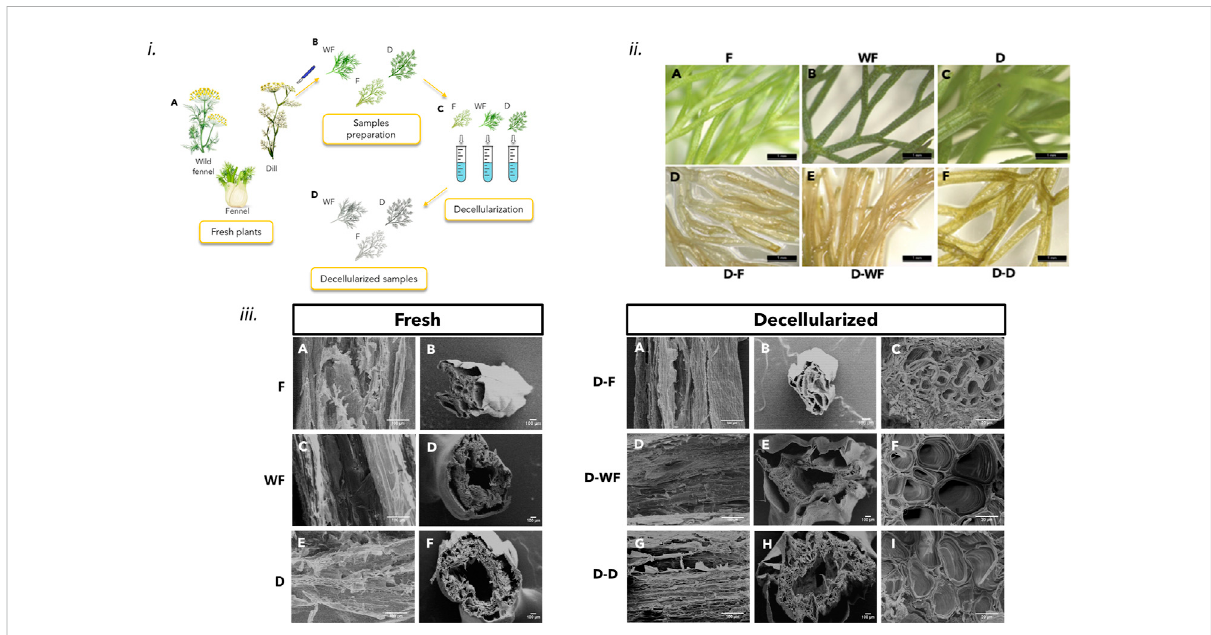
FIGURE 1 i) Schematic procedure for obtaining decellularized leaves from fresh plants: A) fresh plants; B) samples cut to obtain the leaf samples; C) decellularization process; D) decellularized leaf samples. ii) Stereomicroscope images: before (A,B,and C) and after (D,E,and F) the decellularization treatment for samples of (A,D) fennel (F), (B,E) wild fennel (WF) and (C,F) dill (D); scale bar: 1 mm iii) SEM images: before (Fresh) and after (Decellularized) of F, WF, and D: axial cross-section of the stem (Fresh: A,C,and E; Decellularized: A,D,and G); transversal cross-section of